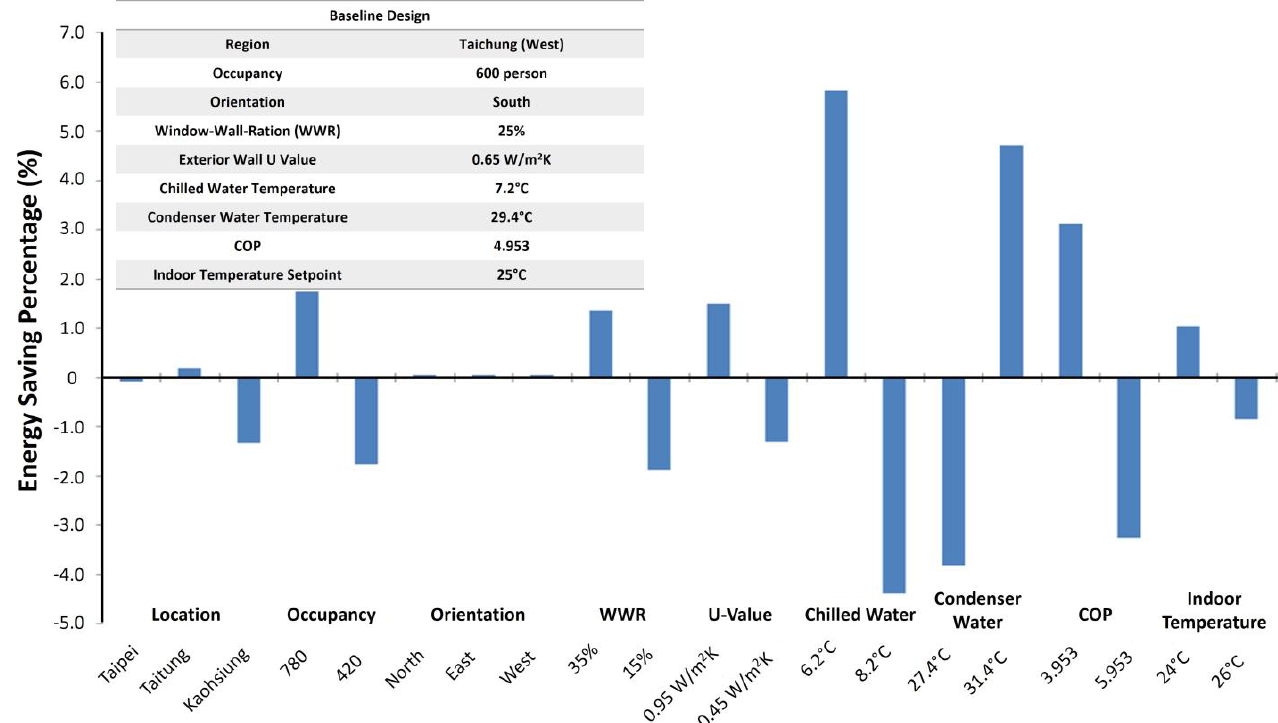
Figure 10. Energy saving percentage based on different studies.